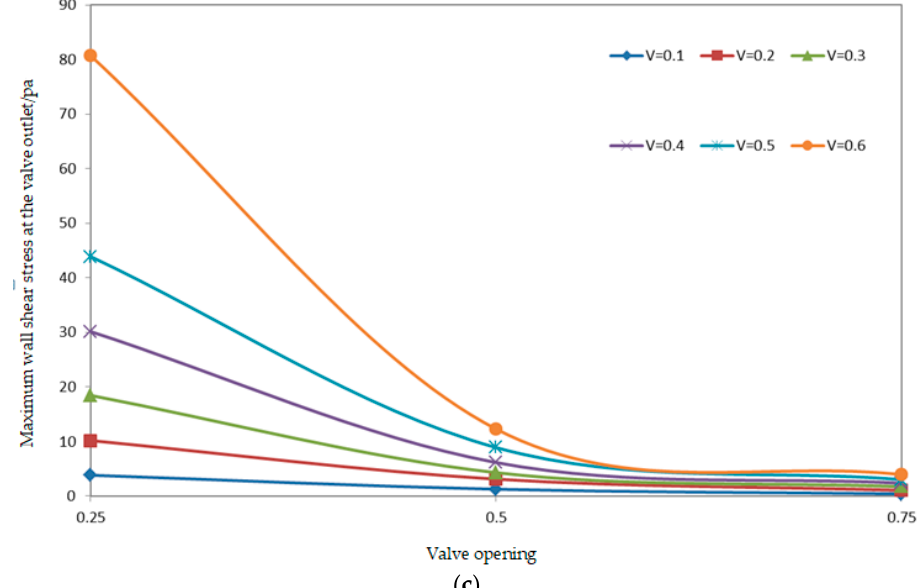
Figure 24. The influence of valve opening on the erosion of the valve; ( a ) Trend of maximum wall pressure; ( b ) Trend of maximum wall shear stress at the valve inlet; ( c ) Trend of maximum wall shear stress at the valve outlet.